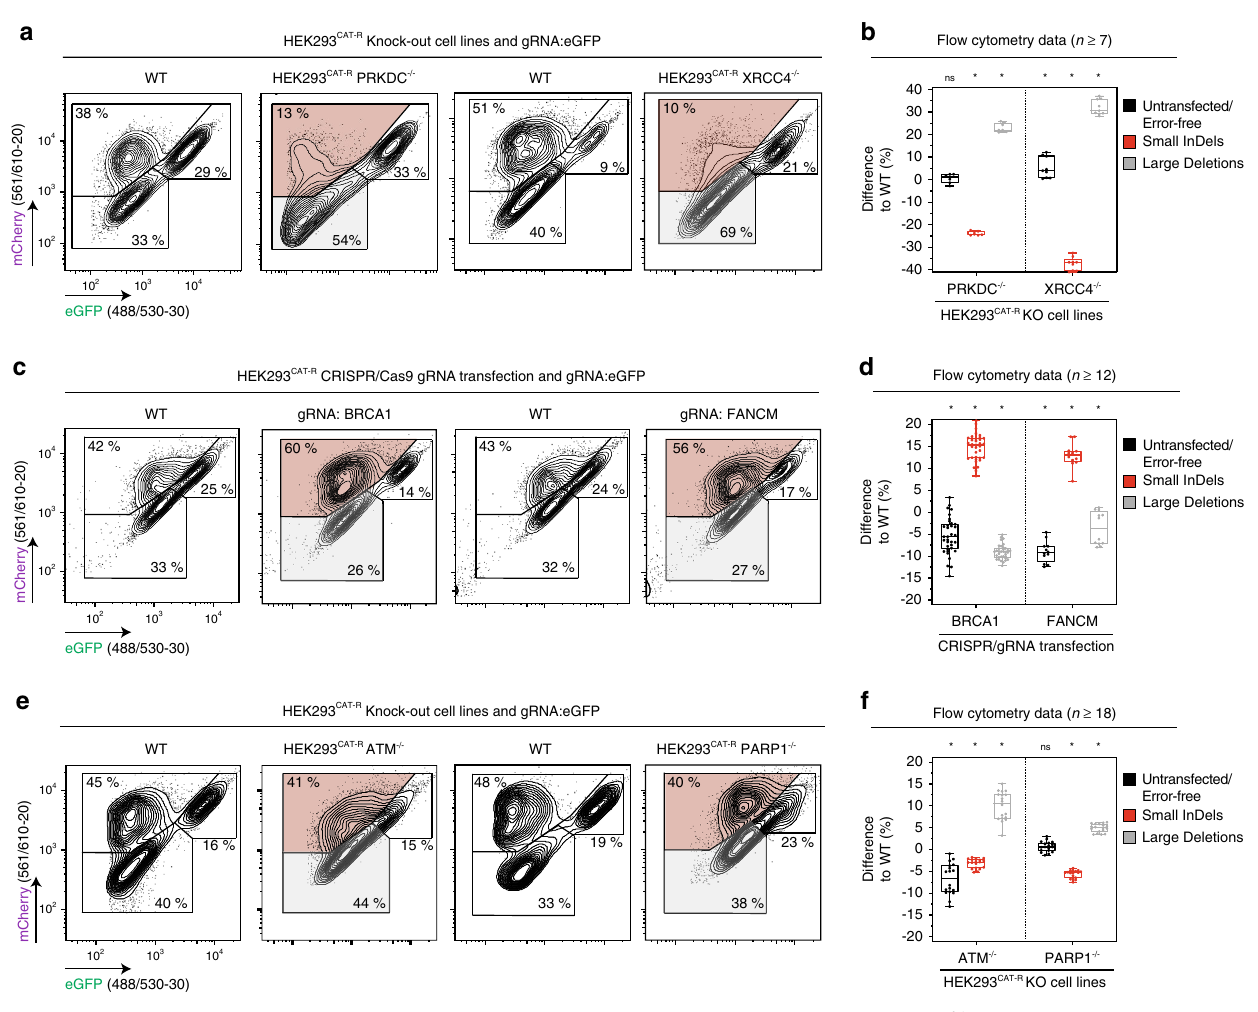
Fig. 2 DNA repair de fi ciencies in fl uence CAT-R response. Representative fl ow cytometry analysis plots of HEK293 CAT-R cells 72 h post-transfection with the synthetic gRNA targeting the eGFP coding sequence in a PRKDC and XRCC4 KO cells, c pool of CRISPR/gRNA transfected cells, and e ATM and PARP1 KO cell lines, each compared to their representative WT controls. Numbers inside plots indicate percentages of live cells. Axes show fl uorescence intensities of eGFP and mCherry proteins. Box and whisker plots ( n PRKDC = 7, n XRCC4 = 9, n BRCA1 = 35, n FANCM = 12, n ATM = 18, n PARP1 = 18, centerlines mark the medians, box limits indicate the 25th and 75th percentiles, and whiskers extend to min and max, showing all points) of fl ow cytometry analysis for HEK293 CAT-R de fi cient or mixed pool CRISPR/gRNA transfected cells are shown in b , d , and f . Values are normalized to wildtype (WT) control, * p ≤ 0.05 versus WT control, multiple comparison analysis testing in ANOVA followed by a Dunnett ’ s test. All individual p -values are included in Source Data fi le 1. Data are derived from a minimum of three independent experiments; n represents the number of